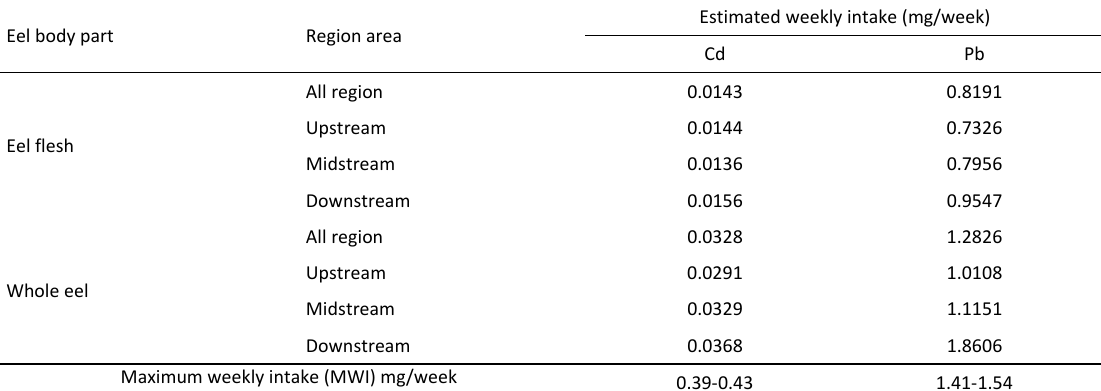
Table 2: The estimated weekly intake of Cd and Pb from eel flesh and whole eel body part